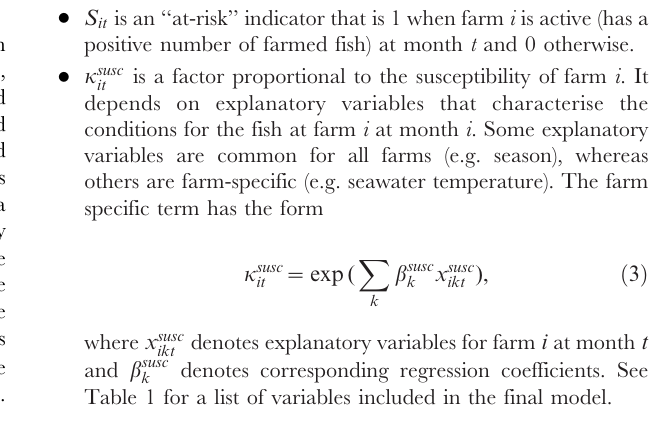
Table 1 for a list of variables included in the final